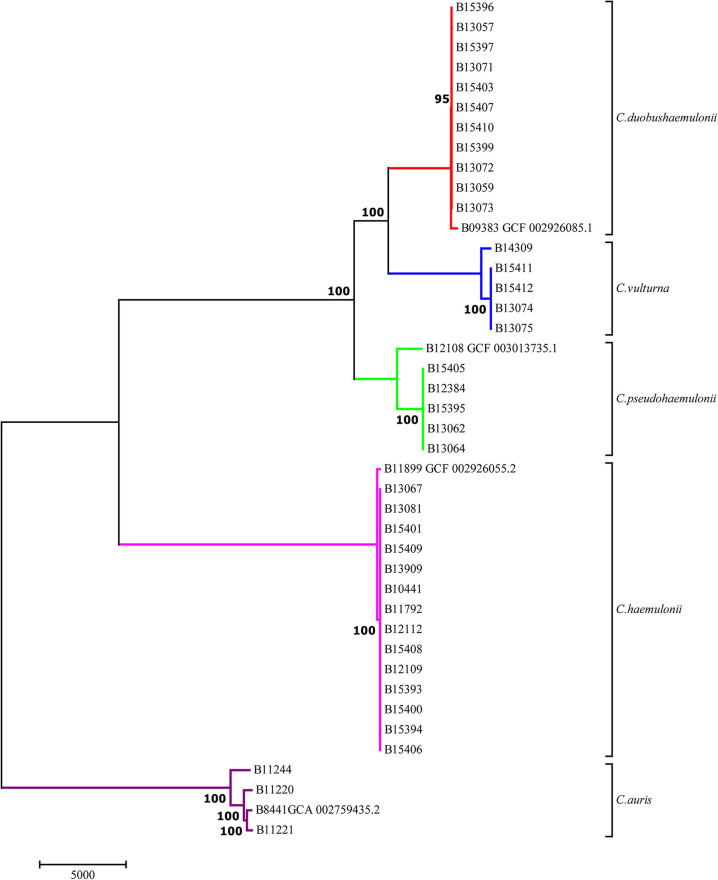
Maximum parsimony tree illustrating the phylogenetic relationships among species from C. haemulonii complex constructed using 56,023 SNPs called against B8441 C. auris reference genome (GenBank accession PEKT00000000.2). Numbers show bootstrap support for the branches. Scale bar shows pairwise SNPs.